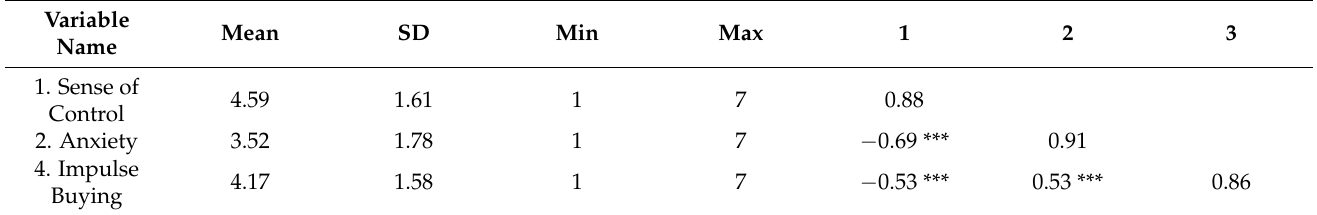
Table A1. Descriptive statistics and correlations of Study 2.